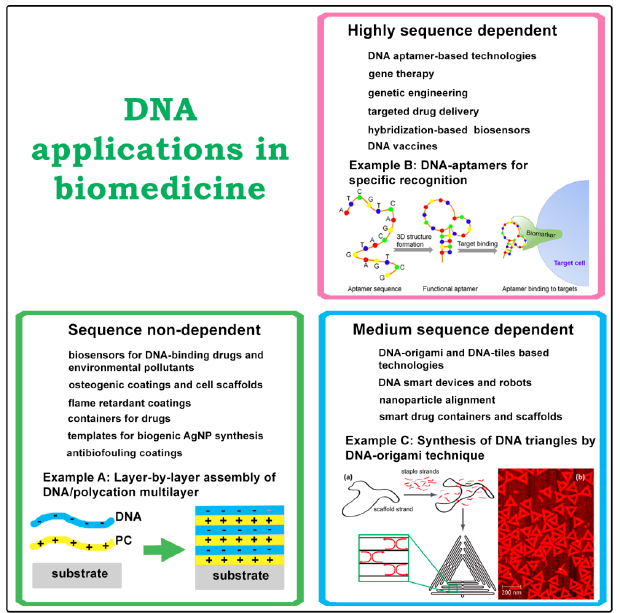
Scheme 1. Main applications of DNA in biomedicine classified by their dependence on the specific nucleotide sequence. Example A: The technique of layer-by-layer assembly of a DNA/polycation (PC) multilayer from oppositely charged DNA and polycation molecules; Example B: Demonstration of specific recognition of a target cell receptor by an aptamer folded in the unique shape due to its specific nucleotide sequence. Reproduced from reference [24] under the CC BY license (http://creativecommons.org/licenses/by/4.0/, accessed on 25 November 2021) Example C: ( a ) Construction of DNA triangular nanostructures from a circular single-stranded scaffold DNA and short oligonucleotide staple sequences complementary to some regions of the scaffold DNA, ( b ) AFM image of triangular DNA structures. Reproduced from reference [25] under Creative Commons Attribution license